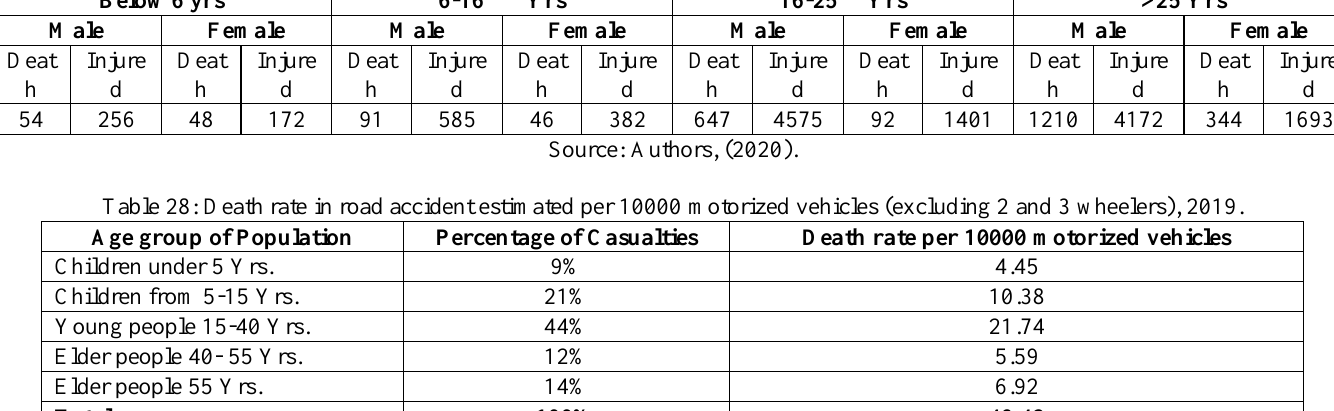
Table 27: Analysis of national data by age of victim, 2019.